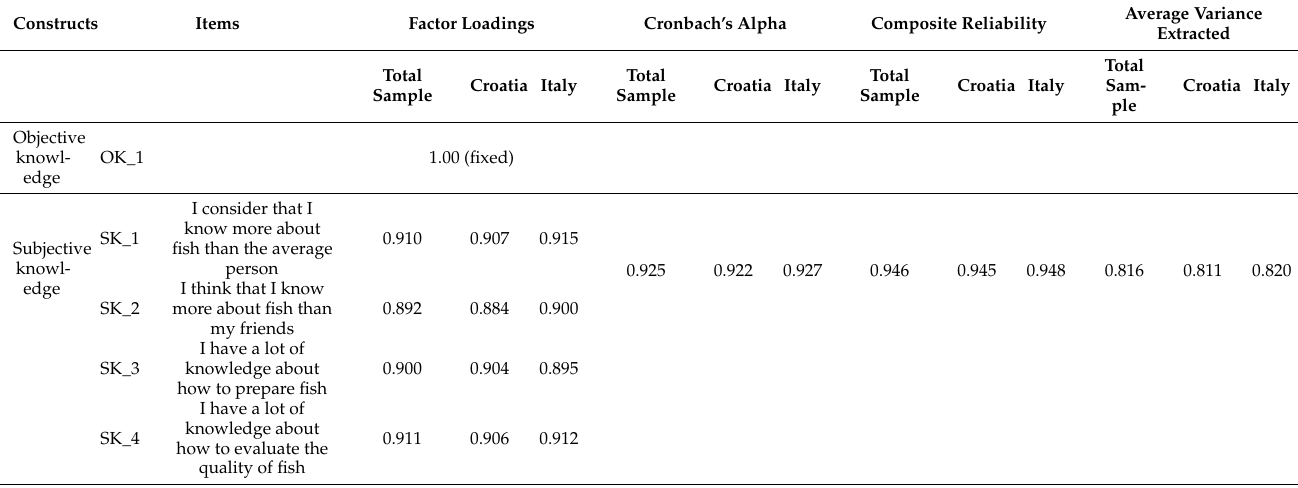
Table 4. Reflective measurement